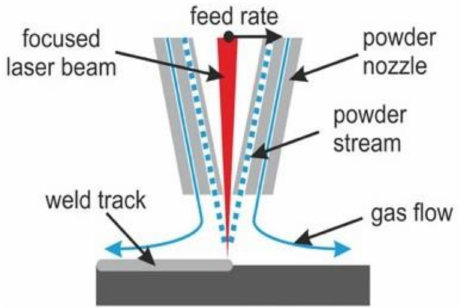
Figure 2. Schematic diagram of DED process. Reprinted from Ref. [31].